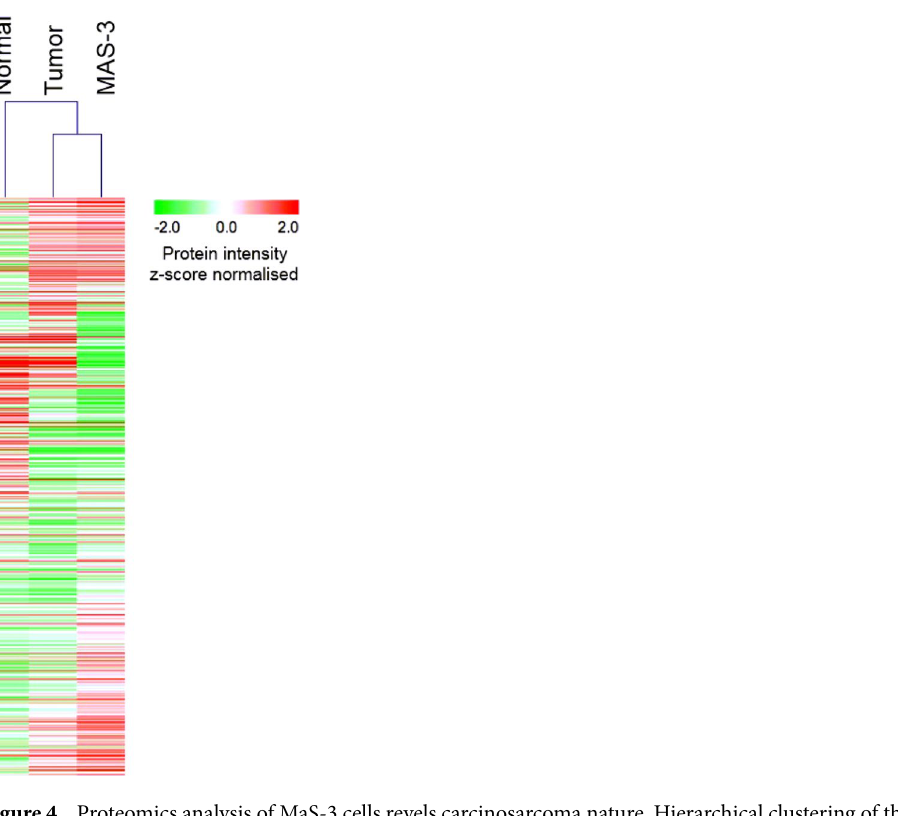
Figure 4. Proteomics analysis of MaS-3 cells revels carcinosarcoma nature. Hierarchical clustering of the core proteome of MaS-3 cells in comparison to carcinosarcoma and corresponding non-malignant